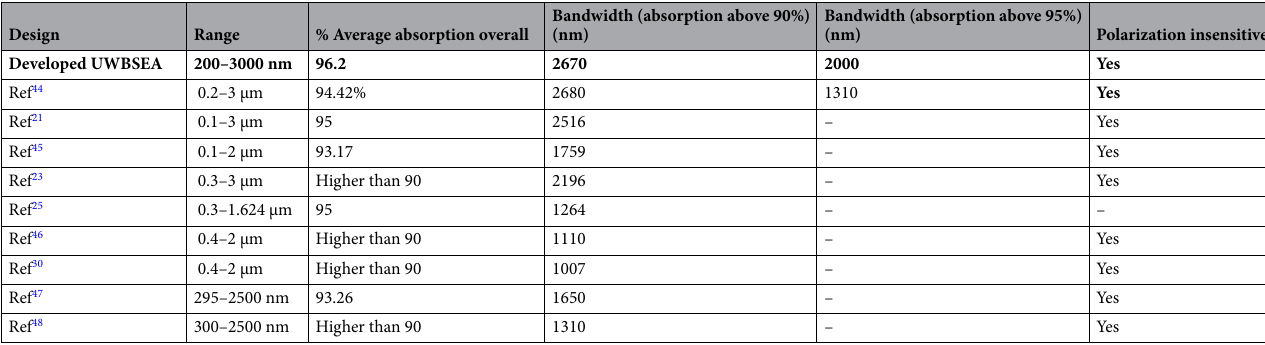
Table 1. Comparison study of developed UWBSEA with available literature. Significant values are in